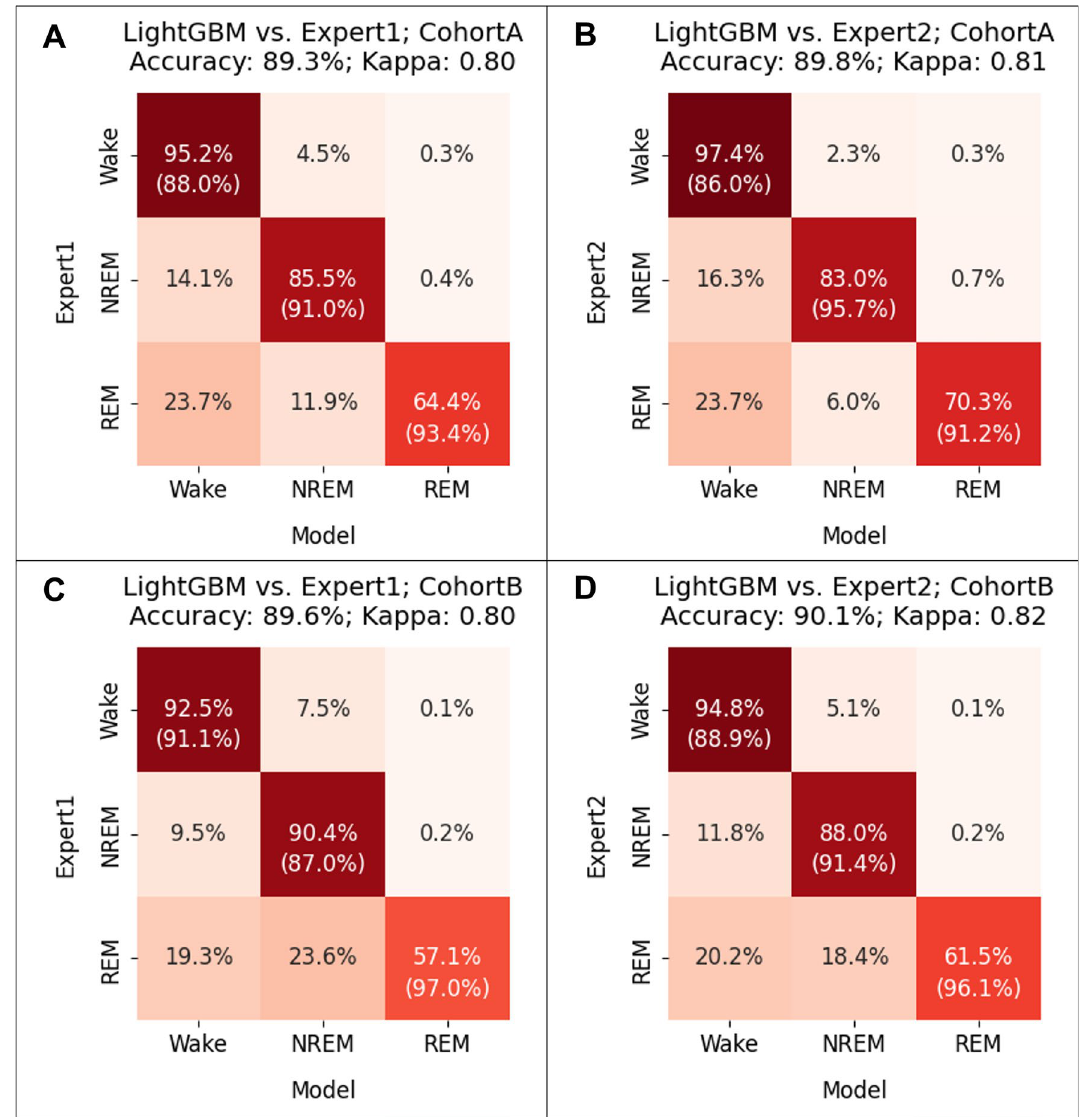
Figure 4. Evaluation of the generalizability of the LightGBM model using a publicly available independent dataset. The performance of the LightGBM model was evaluated across cohorts A (top row) and B (bottom row) against the scores of expert 1 (left column) and expert 2 (right